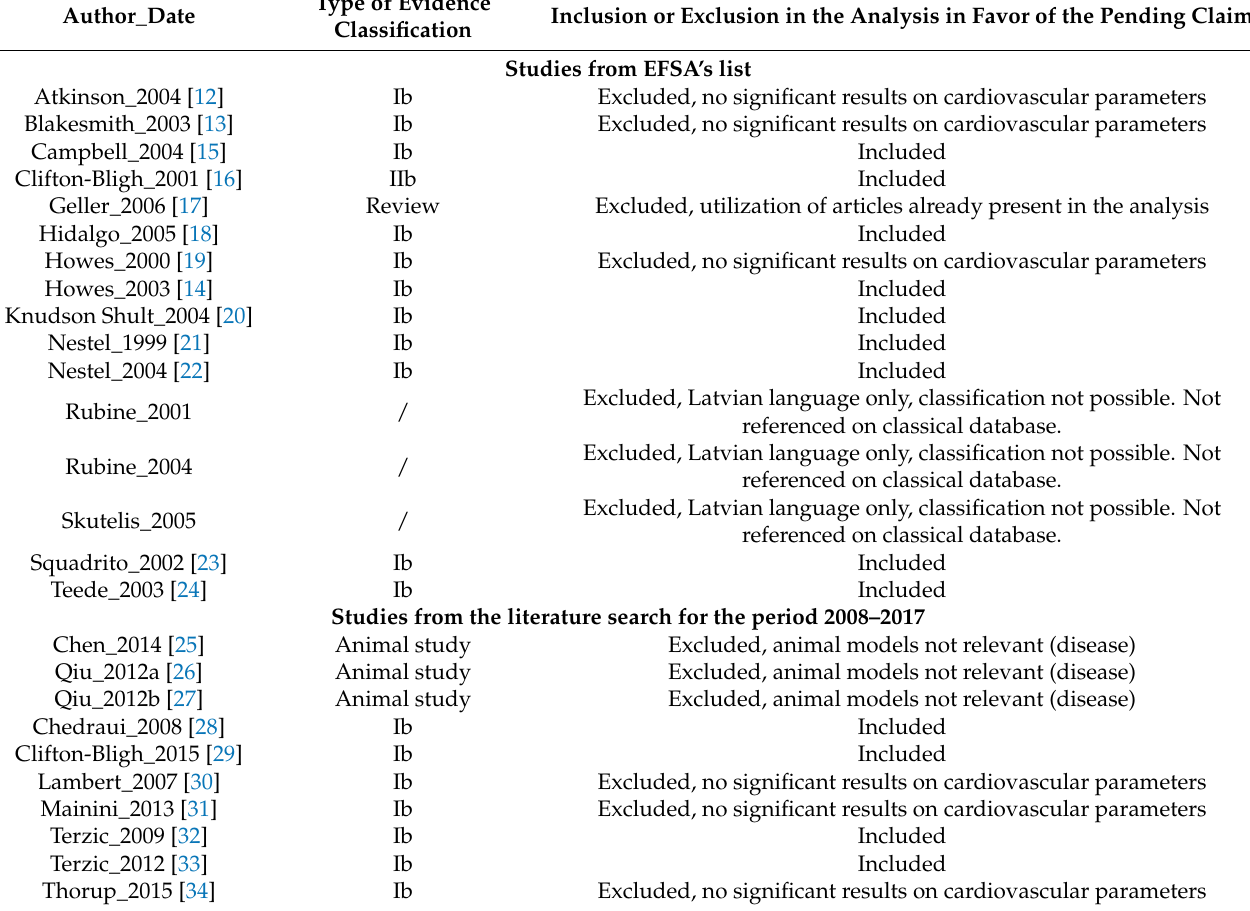
Table 4. Studies classification and exclusion